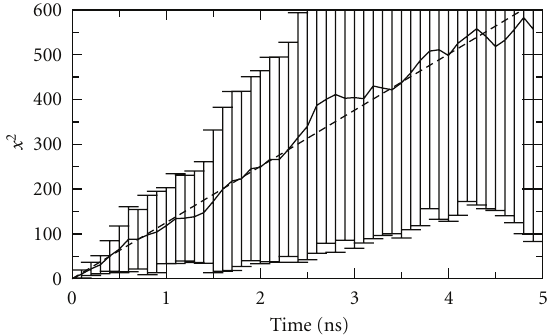
Figure 3: Average of the square displacement from starting position versus time with standard deviations as bars. Averaging is performed over 27 molecules. Data from the simulation reported in